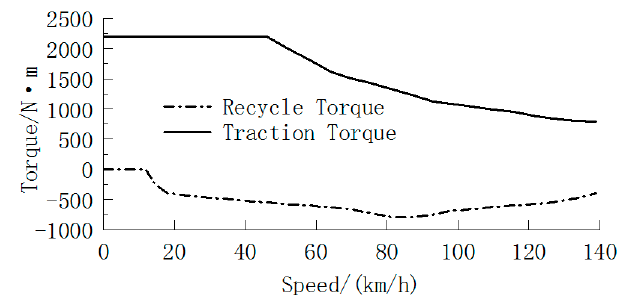
Figure 4. Maximum Traction Torque and Braking Recovery Torque Based on Vehicle Velocity.